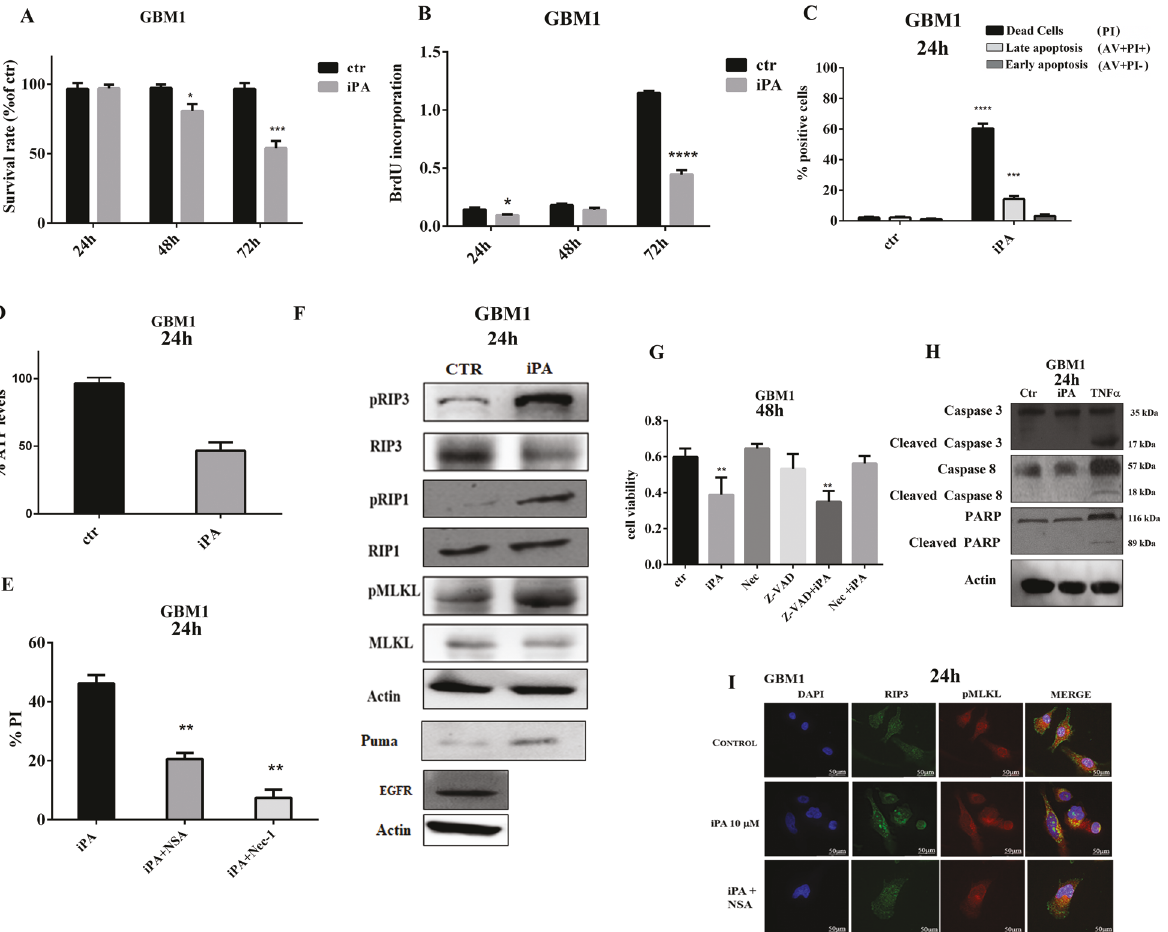
Fig. 6 iPA induces necroptosis in GBM primary cell lines. A Plot showing the survival rate of GBM1 cells after 24, 48, and 72 h of iPA (10 μ M) treatment. B Antiproliferative effect of iPA on GBM1 primary cell line as detected by BrdU assay after 24, 48, and 72 h of treatment with iPA (10 μ M). C GBM1 cell line was treated with 10 µM of iPA for 24 h. Cell death was determined by fl ow cytometry followed by Annexin V/PI staining. Early Apoptosis Annexin V-positive cells (AV + /PI − ); Necrosis: PI-positive and Annexin V-negative cells (AV − /PI + ); and Late Apoptosis (AV + /PI + ). D Plot showing the reduced ATP levels after 24 h of treatment with iPA 10 µM in GBM1 primary cell line. E Plot showing the % of PI- positive cells. GBM1 primary cell line after 1 h of pretreatment with Necrosulfonamide (NSA) (5 μ M) and Necrostatin-1 (Nec-1) (20 μ M) were analysed through PI staining after 24 h of iPA treatment (10 μ M). F Representative Immunoblotting images of Necroptosis protein levels in GBM1 primary cell line after 24 h of treatment with iPA 10 µM. G Plot showing the % of cell viability in GBM1 primary cell line after 48 h of treatment with iPA (10 μ M), RIP1 inhibitor Nec-1 (20 μ M), Caspase inhibitor z-VAD (10 μ M), and two combinations of these drugs: z-VAD (10 μ M) + iPA (10 μ M) and Nec-1 (20 μ M) + iPA (10 μ M). Speci fi cally, GBM1 cells were pretreated with z-VAD or Nec-1 for 1 h, followed by treatment with iPA 10 μ M for 48 h. H Representative Immunoblotting images of Caspase-3, Caspase-8, and PARP1 protein levels in GBM1 primary cell lines treated with iPA 10 µM at 24 h. I Immuno fl uorescence staining of GBM1 cells with RIPK3 (green) and p-MLKL (red) after treatment with iPA 10 µM at 24 h. The nuclei are stained blue with Hoechst. The data are presented as mean ± SD of at least three independent experiments. * p < 0.05, ** p < 0.01, *** p < 0.001, **** p < 0.0001 versus control, represented by cells treated with vehicle (DMSO).